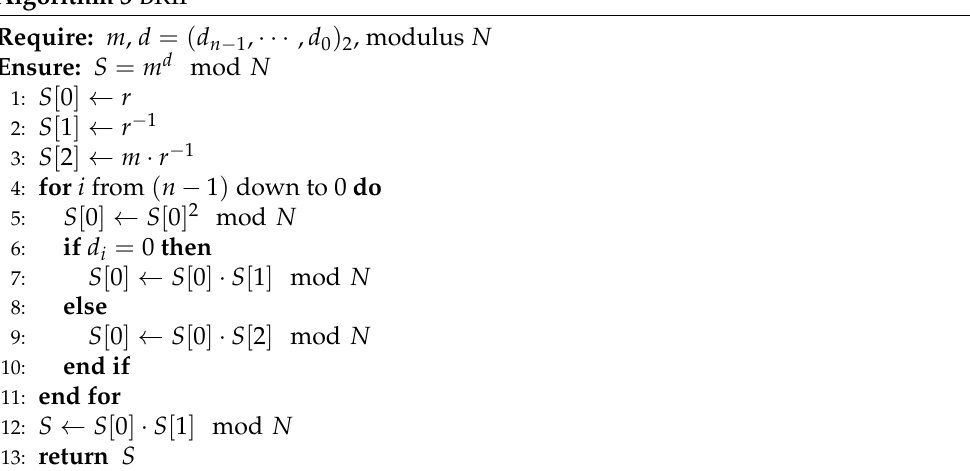
Algorithm 3 BRIP